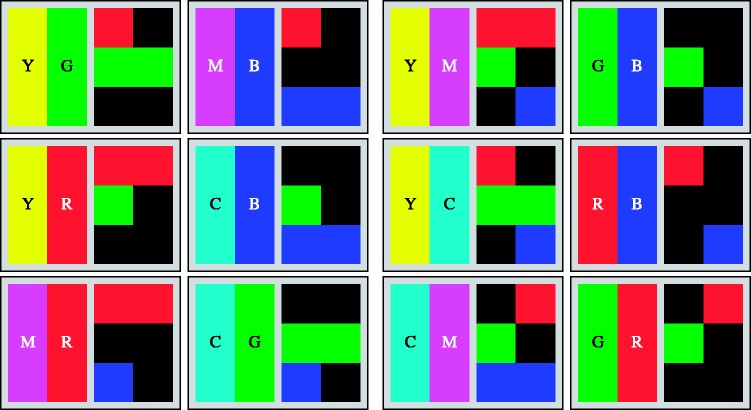
At left, the cases of a transition in a single RGB colour channel with veil in either one of the two remaining RGB colour channels. At right, the case of simultaneous edges in two RGB colour channels, with or without a veil in the third one.